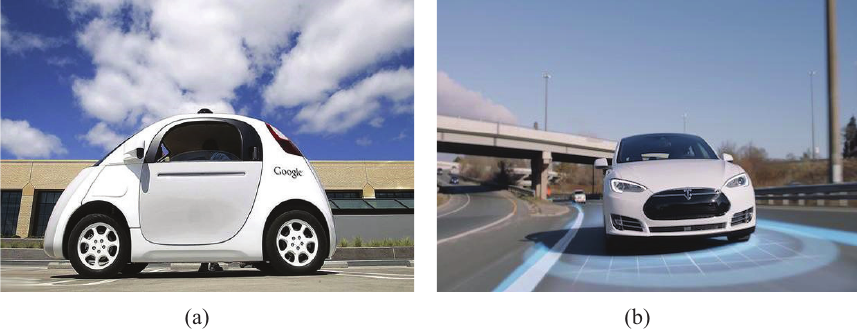
Figure 1. Self-driving cars of Google and Tesla: ( a ) Google’s self-driving car; ( b ) Tesla’s self-driving